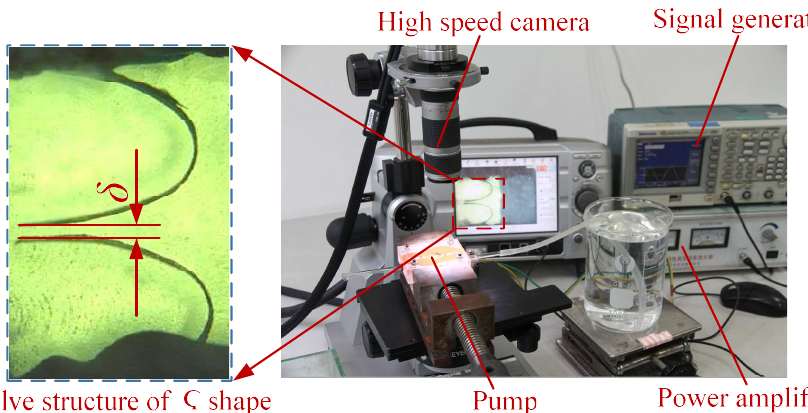
Figure 5. The photographs of experimental observation platform of the piezoelectric-pump high-speed dynamic microscopic image-analysis system.